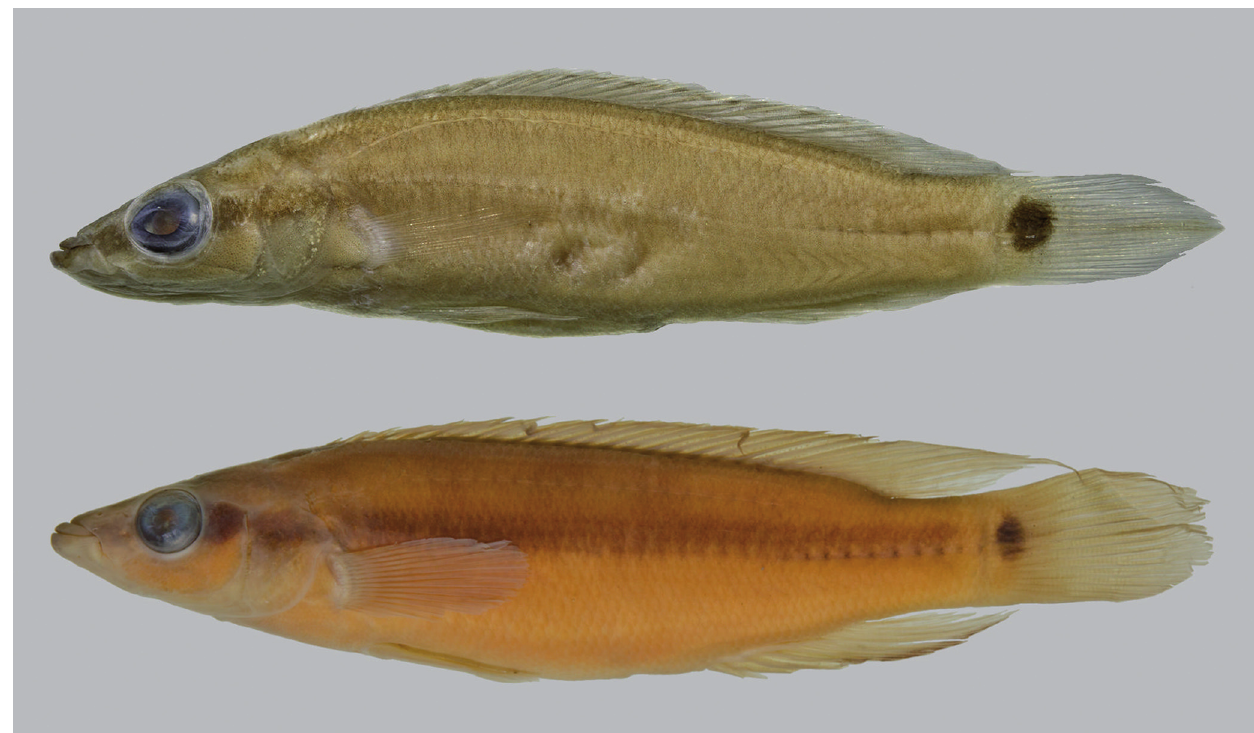
Fig. 6. Caudal blotch pattern in Crenicichla urosema , INPA 7010, 53.5 mm SL (above) and C. virgatula, INPA 2909, holotype, 66.2 mm SL